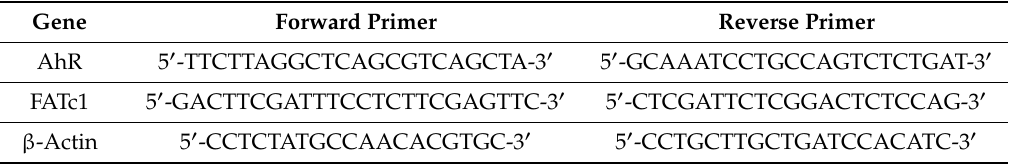
Table 1. List of primer sequences used for qRT-PCR analysis in this study. Gene Forward